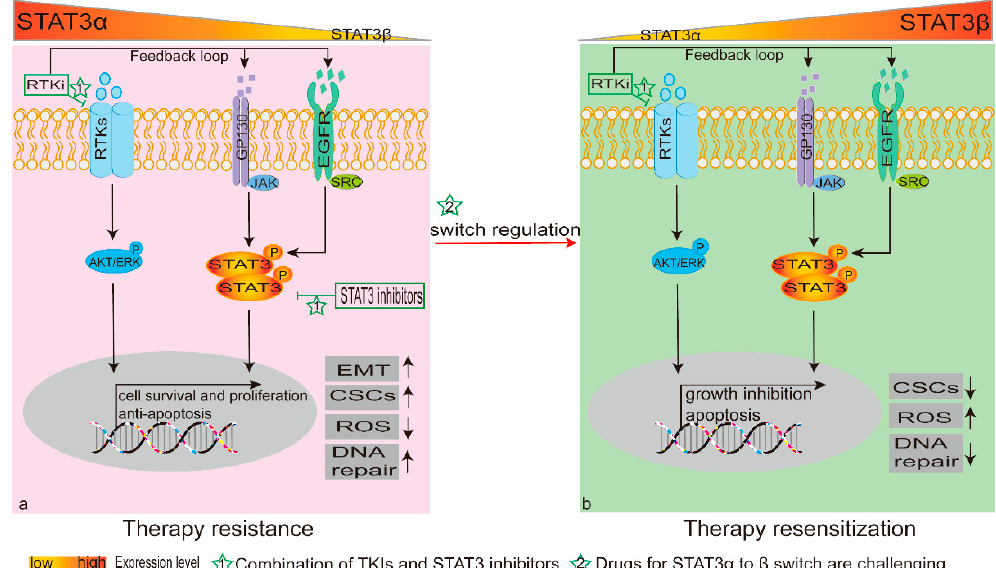
Figure 2. Schematic representation of different ratios of STAT3 α / STAT3 β and their functions in therapy sensitivity. ( a ) The STAT3 signaling pathway confers therapy resistance to cells, mainly by mediating its target genes for cell survival, proliferation and inhibition of apoptosis. It promotes epithelial-mesenchymal transition, restores cancer stem cell properties, enhances DNA repair and attenuates ROS levels. RTK inhibitors can augment cell survival and proliferation via feedback activation of STAT3. Thus, in combination with RTK inhibitors, STAT3 inhibitors can be an effective strategy for therapy resistance. ( b ) STAT3 β activation is better for cell growth inhibition and apoptosis, in contrast with STAT3 α functions. Switch regulation for STAT3 α to STAT3 β is a challenging approach for resensitization to chemotherapy. In the context of a high expression level of STAT3 β , RTK inhibitors that activate STAT3 via a feedback loop may be of benefit for cell apoptosis. Abbreviations: AKT, protein kinase B; CSCs, cancer stem cells; EGFR, epidermal growth factor receptor; EMT, epithelial-mesenchymal transition; JAK, Janus kinase; P, phosphorylation; PCBP1, poly-C binding protein-1; ROS, reactive oxygen species; RTKi, receptor tyrosine kinase inhibitor; RTKs, receptor tyrosine kinases; STAT3, signal transducer and activator of transcription 3.